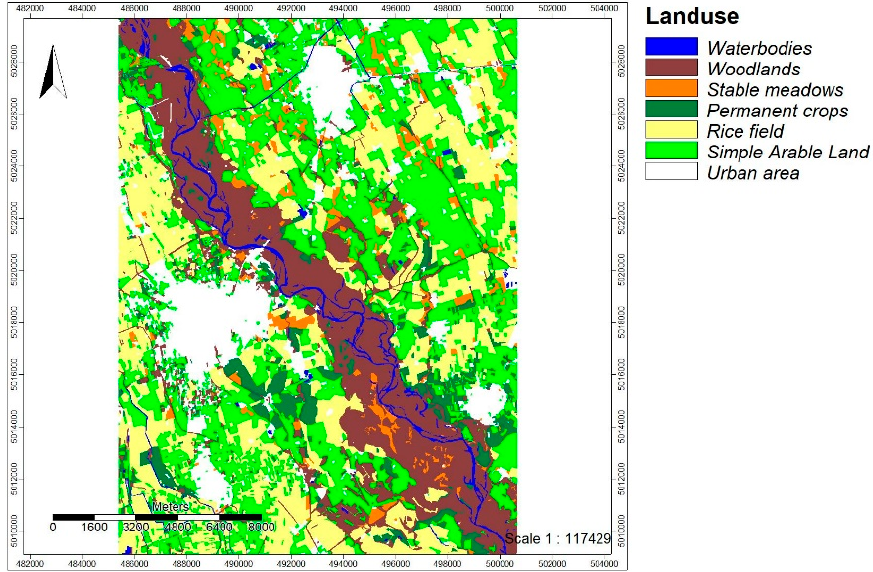
Figure 3. Land use and land cover map for the year 2018 (source: geoportale Lombardia).